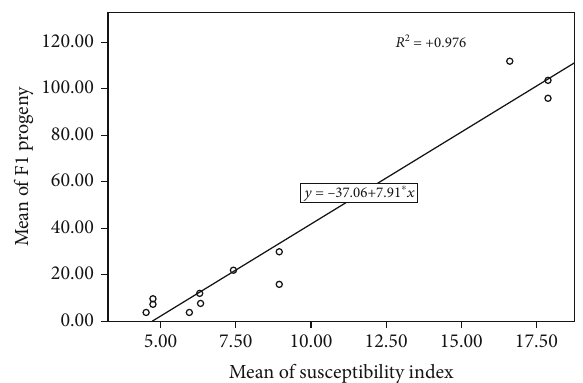
Figure 1: Correlation between Dobie ’ s index of susceptibility (DI) and number of F1 progeny.